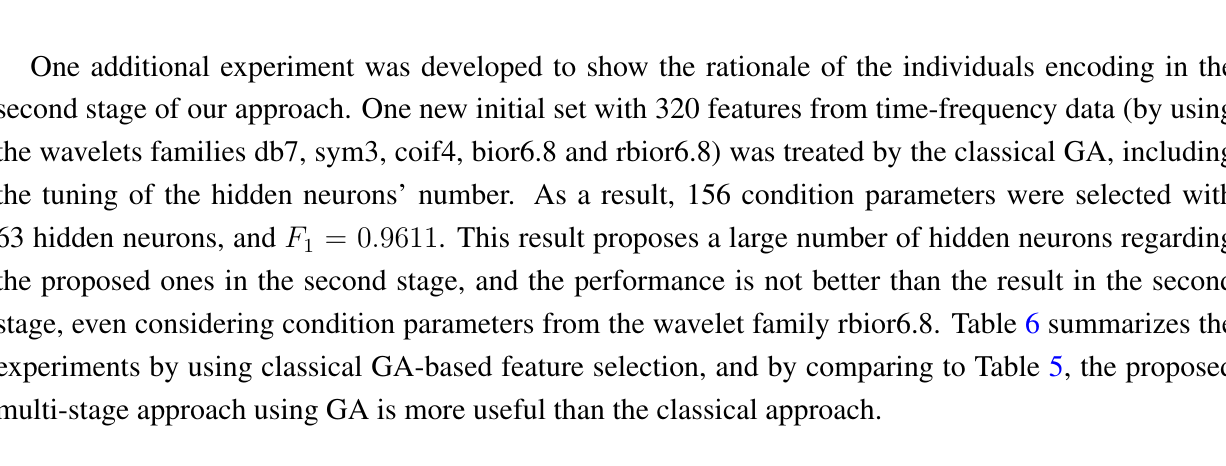
Table 6. Classifier performance by using classical feature selection with